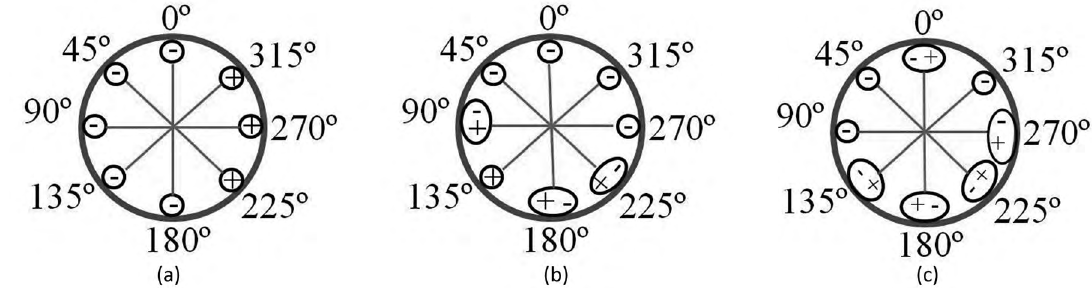
Figure 12. Distribution of residual stress in the peripheral radial positions of the raw material (a) horizontal (b) and vertical (c) pre- straightened